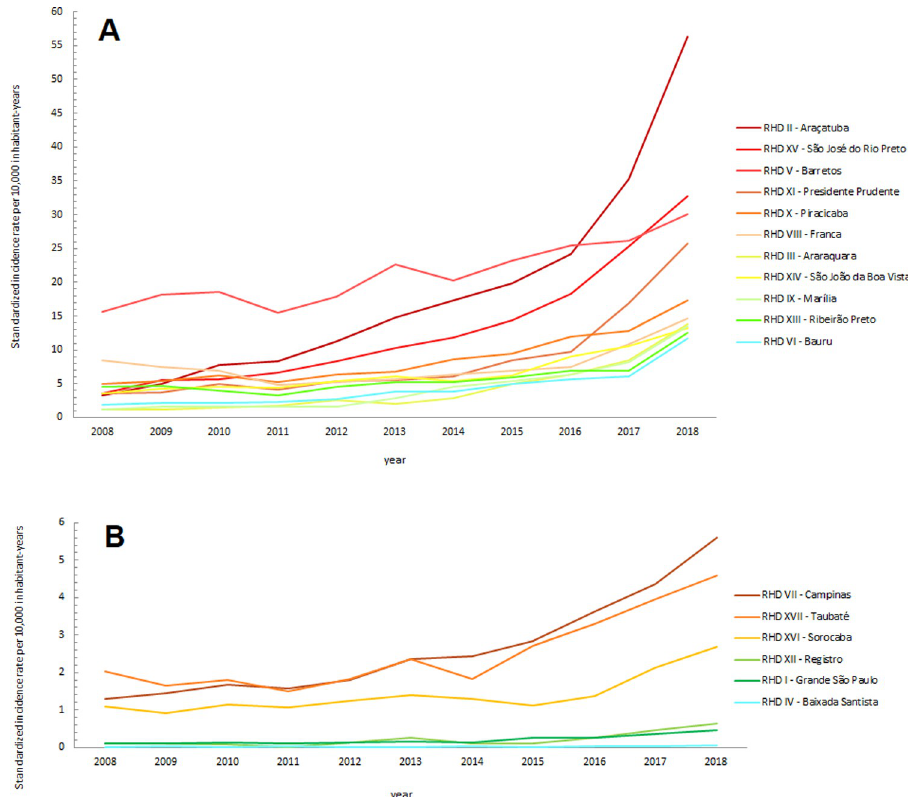
Fig 4. Standardized incidence rates of scorpion envenomations (per 10,000 inhabitant-years) for the Regional Health Districts (RHDs) located in the western, northern, northwestern, and central portion (A), and in the eastern and southern portion (B) of the state of S ã o Paulo, from 2008 to